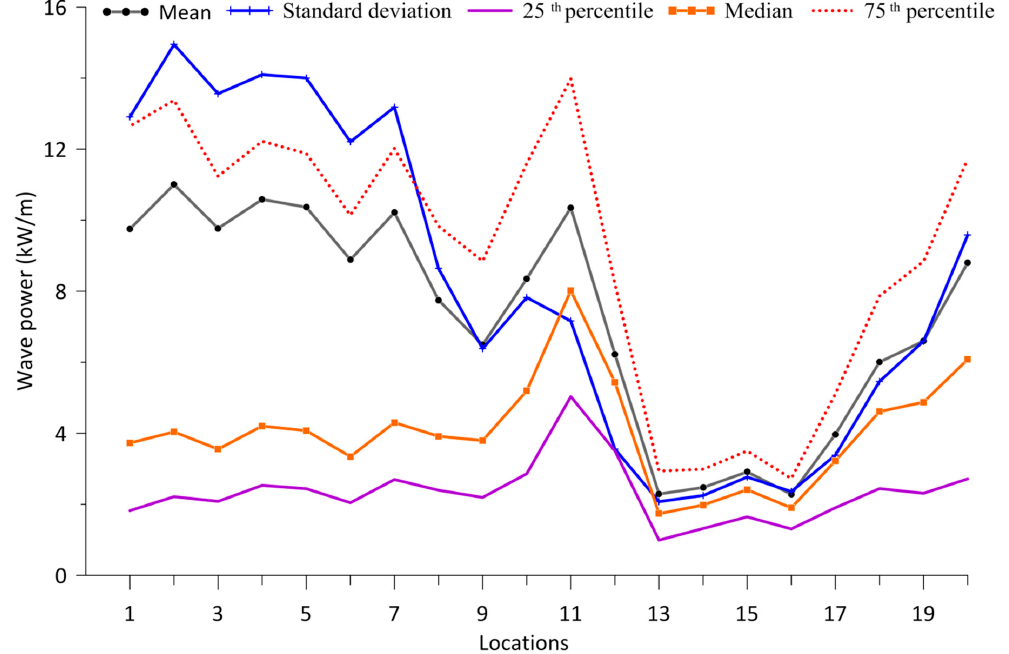
Figure 10. Plots of mean, median, 25th percentile, 75th percentile, and standard deviation of wave power from 1979 to 2018 at 20 locations.